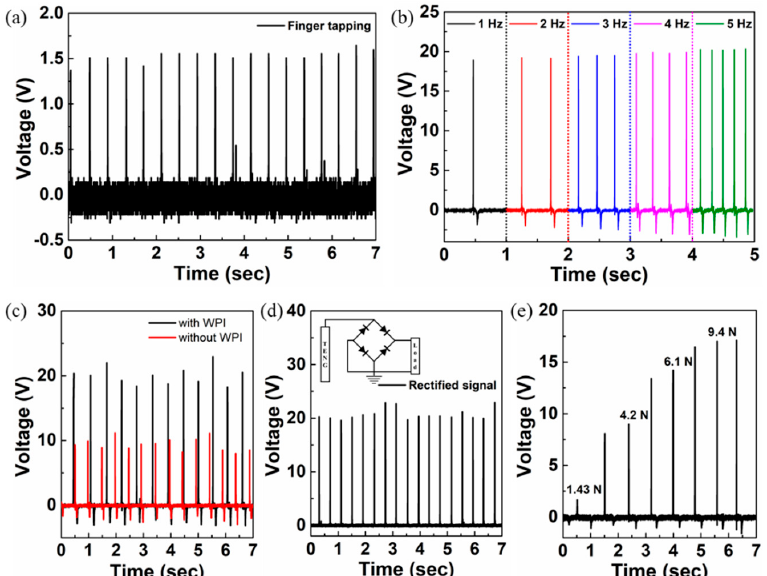
Figure 5. Output voltages of the TENG device under various circumstances: ( a ) finger tapping, ( b ) different frequencies, ( c ) with and without WPI film, ( d ) rectified Wheatstone bridge connection, and ( e ) various loads of the bio-TENG device.